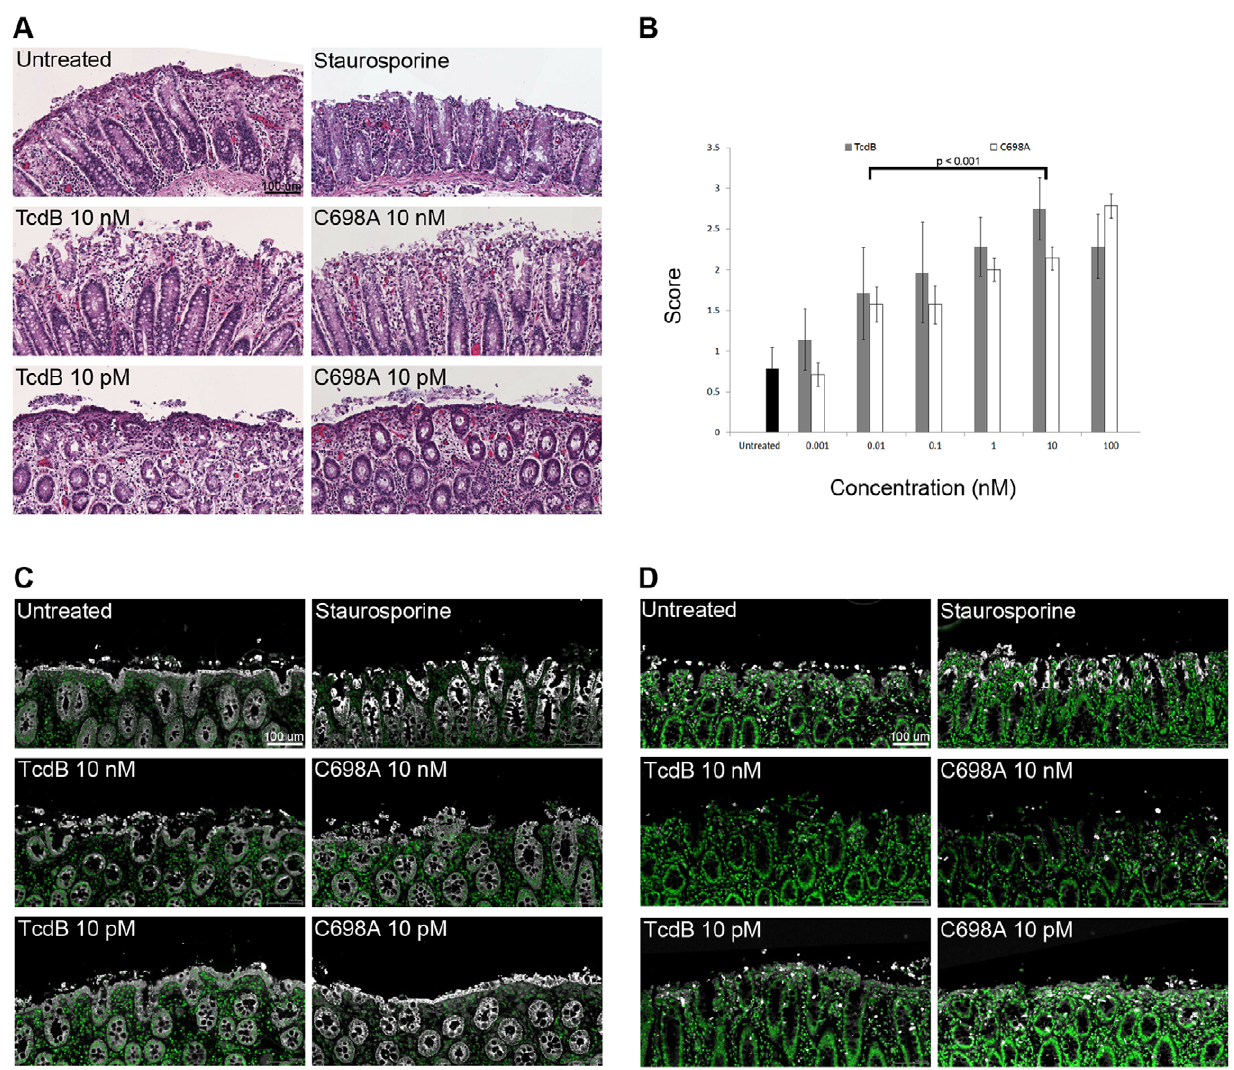
Figure 6. TcdB and TcdB C698A cause epithelial damage in porcine colonic explants. Porcine colonic explants were treated with 1 mM DTT to remove the mucus layer, washed with PBS, and incubated with toxin at 37 u C for 5 hours. A , Tissue sections were stained with H&E. B , The H&E slides were scored in a blinded fashion using a semi-quantitative injury scale: 0- no damage; 1-superficial damage, damage limited to intact surface epithelial cells; 2-loss of up to 50% of surface epithelial cells or gland length, crypts intact; 3-loss of over 50% of surface epithelial cells and damage in greater than 50% of gland length. An injury score was calculated as the mean score for sections analyzed seven times by six individuals. Statistical analysis was performed using a two-way ANOVA and post-hoc tests. These analyses revealed a significant difference in the scores given to tissues treated with the toxins over the range of concentrations (p , 0.001), while there was no statistical difference between tissues treated with TcdB and TcdB C698A. A subsequent Bonferroni’s test revealed that scores given to tissue treated with 10 nM TcdB and 10 nM TcdB C698A were significantly different from scores given to tissue treated with 10 pM TcdB or 10 pM TcdB C698A (p , 0.001). Error bars correspond to the standard deviation between the seven scores. C , The sections were also stained with an anti-pan keratin and D , anti-active caspase-3 antibody. Representative images of H&E, pan-cytokeratin, and active caspase-3 staining (white – pan-cytokeratin/active caspase-3, green – DAPI) show significant damage to the epithelium of the colon at concentrations of TcdB and TcdB C698A that kill cells (10 nM). At concentrations that induce rounding but not death in cultured cells (10 pM), there was no significant damage to the tissue surface cells. Caspase-3 activation was not detected at levels above background in any of the TcdB-treated